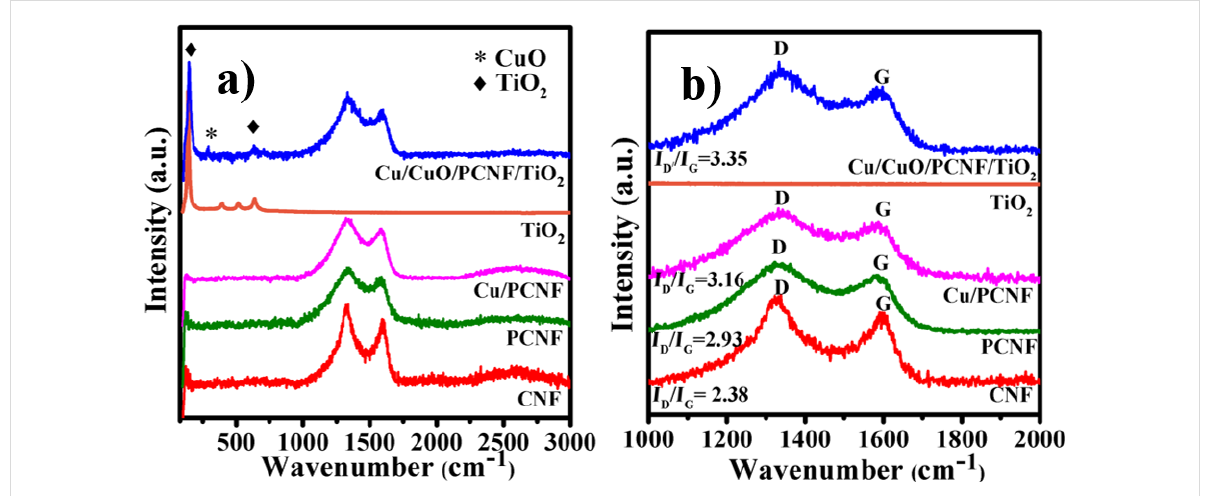
Figure 4: (a) Raman, spectra of CNF, PCNF, Cu/PCNF, TiO 2 and Cu/CuO/PCNF/TiO 2 composites and (b) Raman spectra of CNF, PCNF, Cu/PCNF, TiO 2 and Cu/CuO/PCNF/TiO 2 composites in the range of 1000–2000 cm − 1